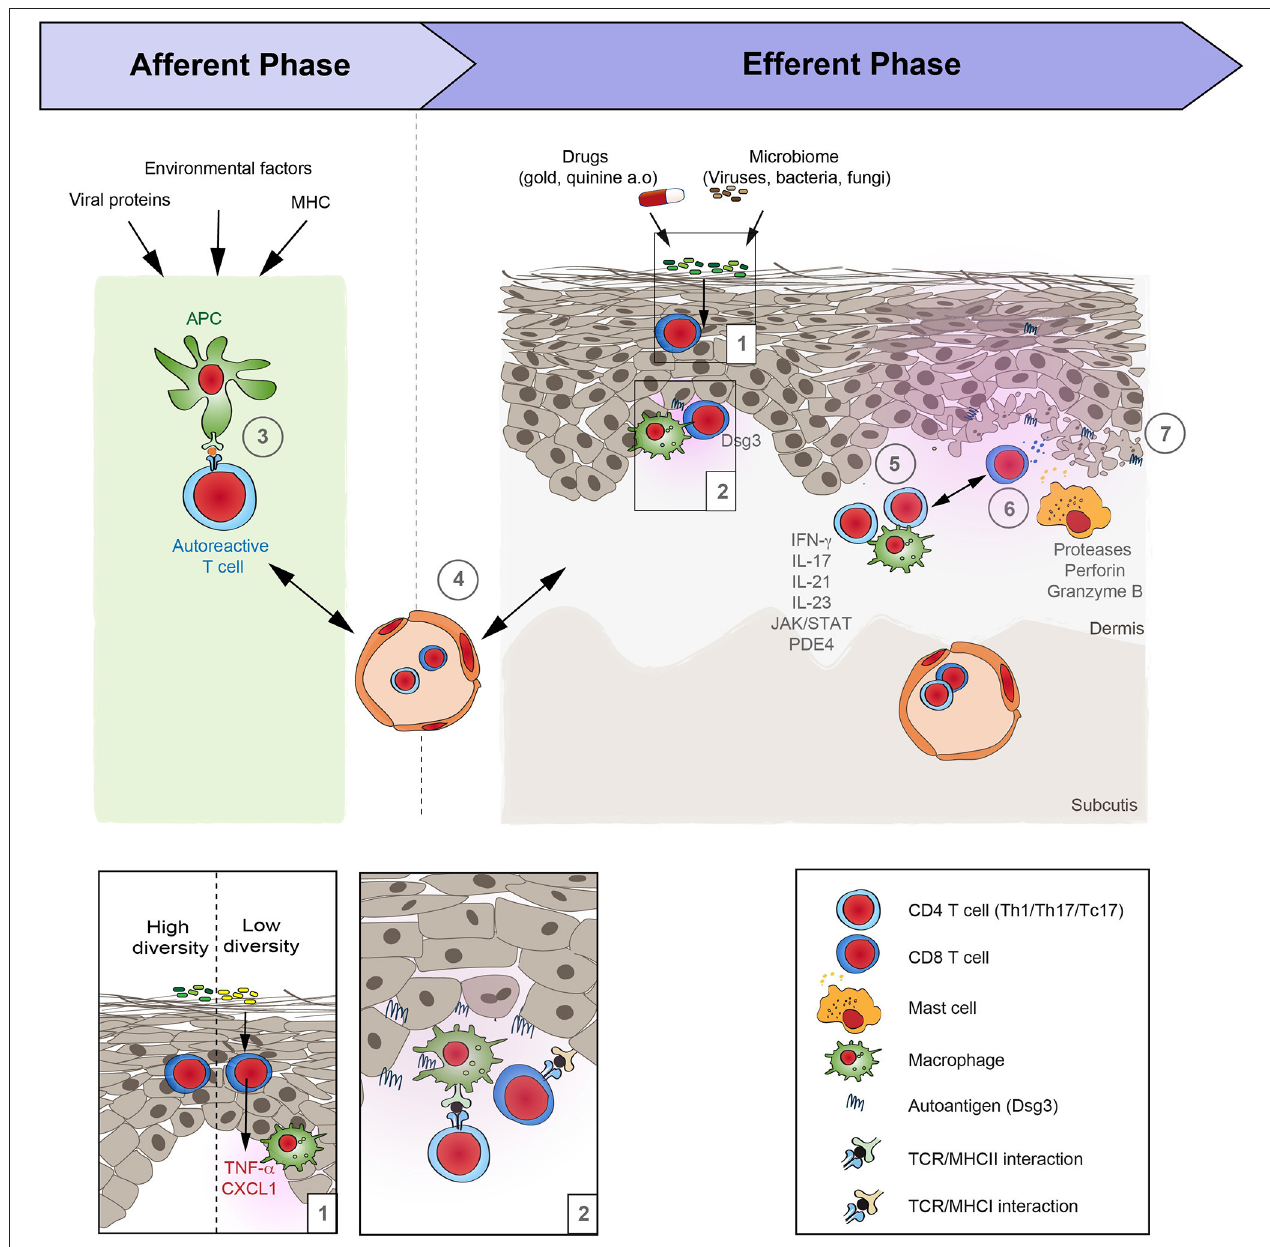
FIGURE 2 | Schematic overview of lichen planus pathogenesis. Based on the increasing evidence of the autoimmune nature of lichen planus (LP), its pathogenesis may be divided in two distinct phases: Afferent phase, where tolerance to autoantigens is lost, and the efferent phase that is characterized by a T cell-driven skin inflammation. (1) Under steady state conditions the diversity of the cutaneous microbiome can alter the “inflammatory state” of the skin. If the diversity of the bacterial communities on the skin is low, this is associated with an increased expression of pro-inflammatory cytokines such as TNF α and CXCL1, as well as an increase of CD11c, suggesting an increased presence of macrophages. (2, 3) Following this presumed injury, the loss of tolerance in LP occurs in the context of an association with the MHC that may additionally be shaped by associated viral infections and other environmental factors. The site of the APC/T-cell interaction is so far unknown. It may occur locally and/or in skin draining lymph nodes. (4) Next, autoreactive T cells reach the skin by extravasation from the blood vessels. (5) Within the skin, T cells become activated by binding to the specific autoantigens. Effector functions of cytotoxic T cells is mediated by (6) proteases, such as granzyme B, as well as perforin. In addition, (7) mast cells become activated and may further aggravate inflammation in LP. However, the precise sequence of events and their interactions are only incompletely understood. with epidermotropism with basal vacuolar degeneration and (97). Transfer of Dsg3-specific T-cells into immunodeficient colloid bodies (2). Furthermore, desmoglein (Dsg) 3-specific T- mice induced an interface dermatitis (a distinct form of T-cell– mediated autoimmunity) in mice. The induction of the interface cells are also capable of inducing histologically LP-like changes